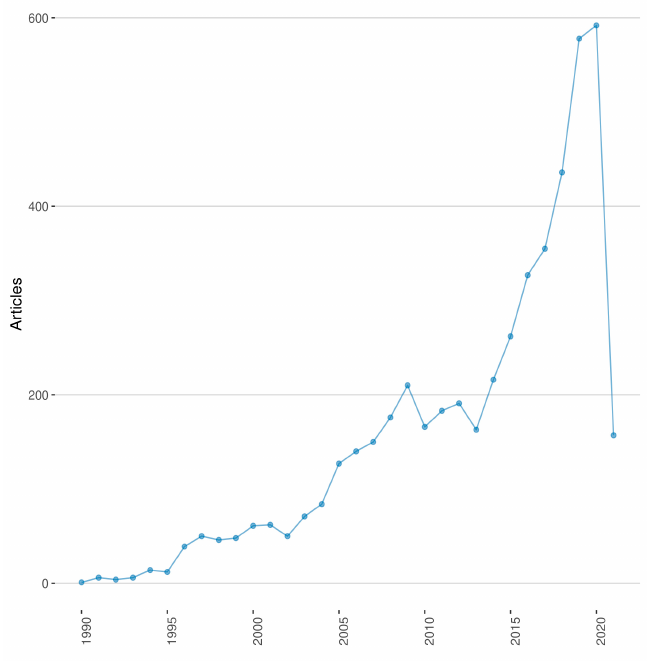
Figure 1. Article count through time.